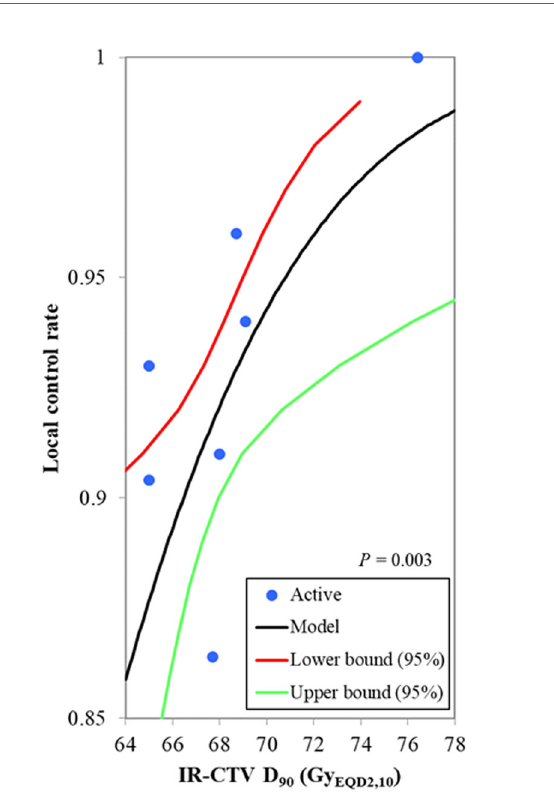
FIGURE 1 | The probit model for the relationship between the HR-CTV D90 and local control probability. The blue active point represents the values of the HR-CTV D90 and the local control probability for each study. The HR- CTV D90 corresponding to a probability of 90% local control was 79.1 Gy EQD2,10 (95% con fi dence interval: 69.8 – 83.7 Gy EQD2,10 ), p < 0.001.